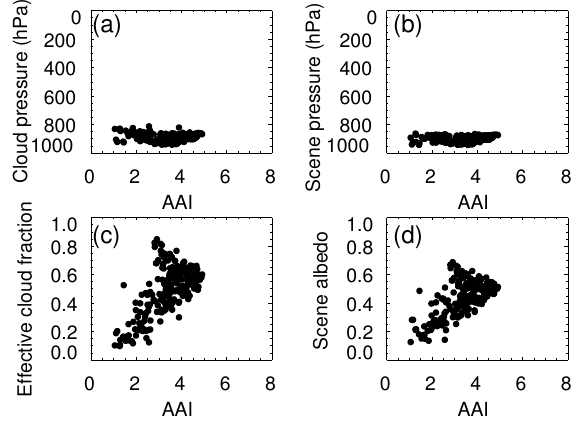
Fig. 17. Scatter plots of FRESCO (a) cloud pressure, (b) scene pres- sure, (c) effective cloud fraction, and (d) scene albedo versus ab- sorbing aerosol index (AAI) from GOME-2 measurements of the biomass burning smoke event in South-West Africa on 6 August 2010 around 08:48UTC. The pixels used in the scatter plots are marked with a box in Fig. 16 in the region of and [5, 15] ◦ S and [10, 15] ◦